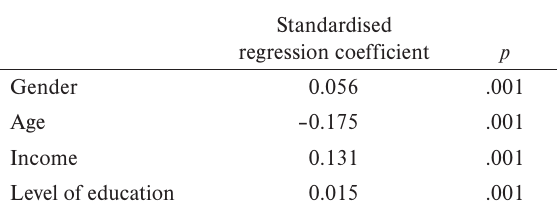
Regression model